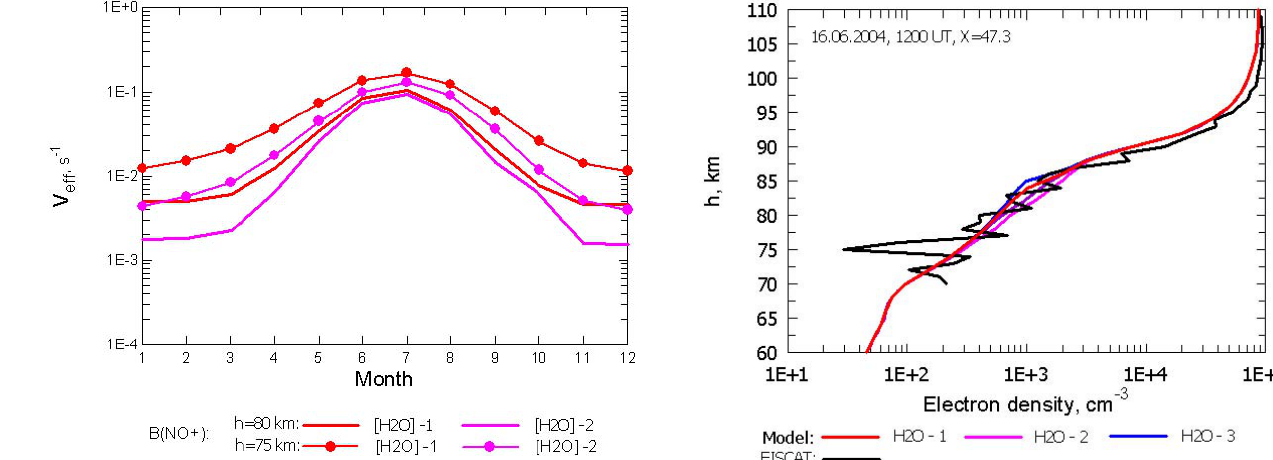
Fig. 4b. Seasonal variation in the B (Cl + based on the H 2 O-1 and H 2 O-2 profiles for 75km.